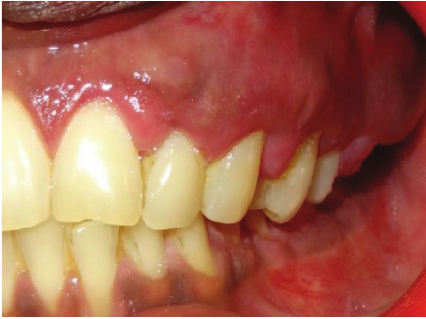
Figure 6: Intraoral view showing gingival overgrowth.